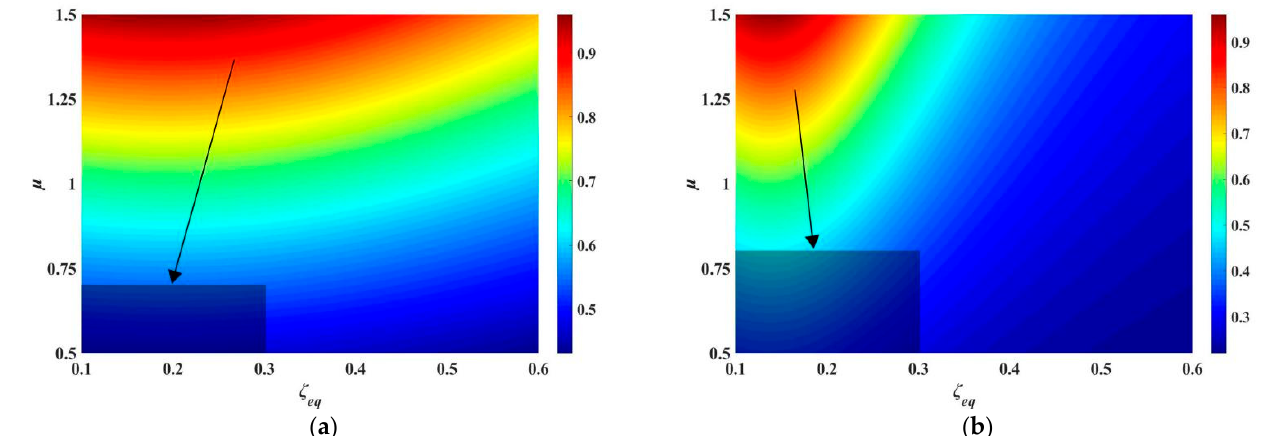
Figure 12. Contour plot of γ SF of LB–1 : ( a ) κ = 0.05; ( b ) κ = 0.1 .